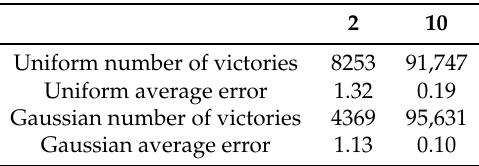
Table 3. Results for k = 2 vs.